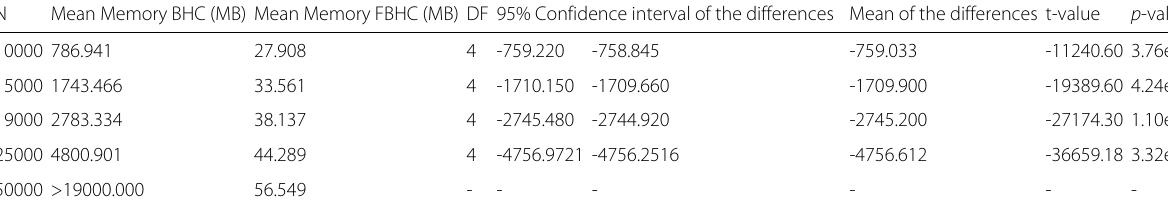
Table 3 Statistical evaluation of the memory usage of the FBHC method compared to the BHC N Mean Memory BHC (MB) Mean Memory FBHC (MB) DF 95% Confidence interval of the differences Mean of the differences